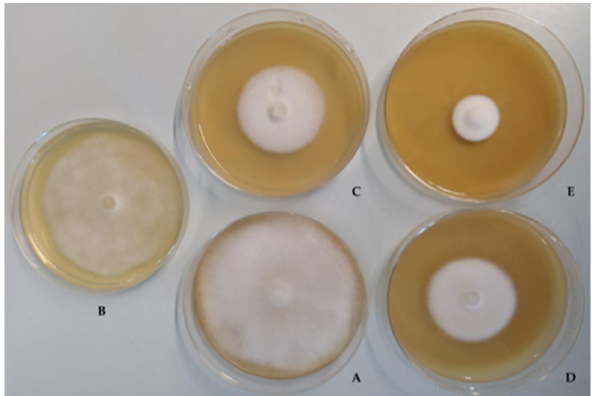
Figure 2. Inhibitory activity of L. plantarum LP100 against A. apis DSM 3116 after 8 days on MEA